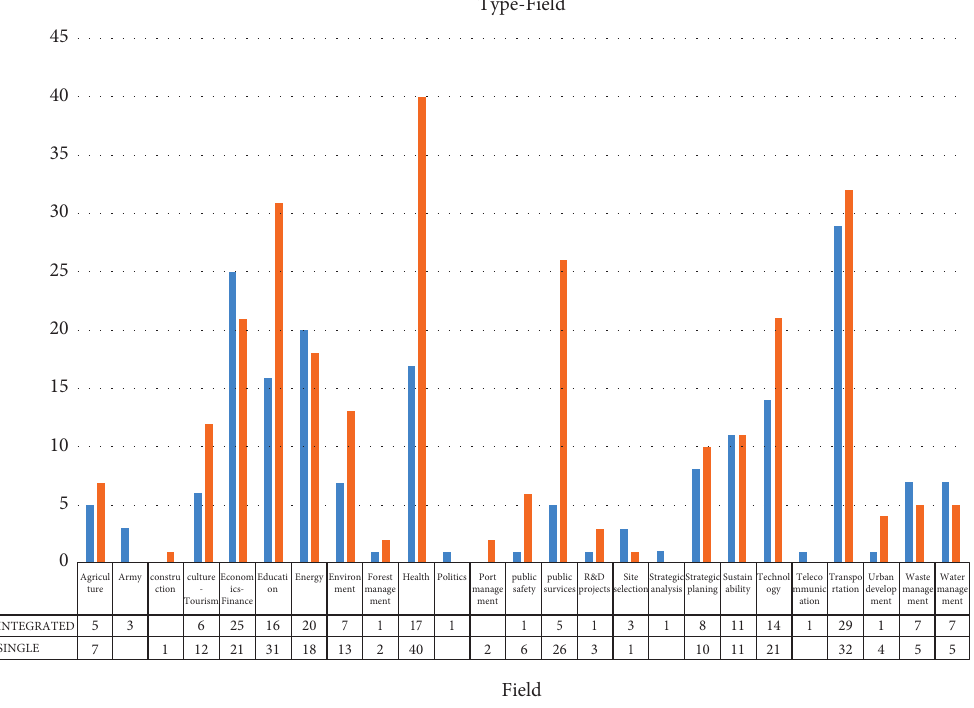
Figure 8: Crosstabulation by type and research